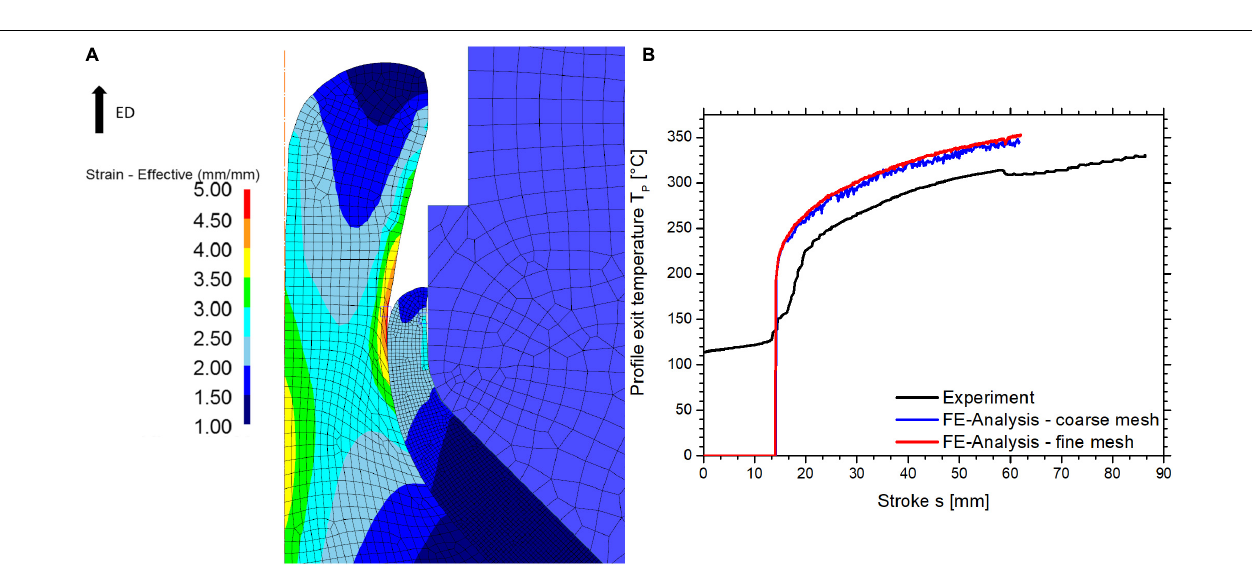
FIGURE 8 | Extrusion diagram of experiment and FE-analysis and simulated material flow in different states of the extrusion.